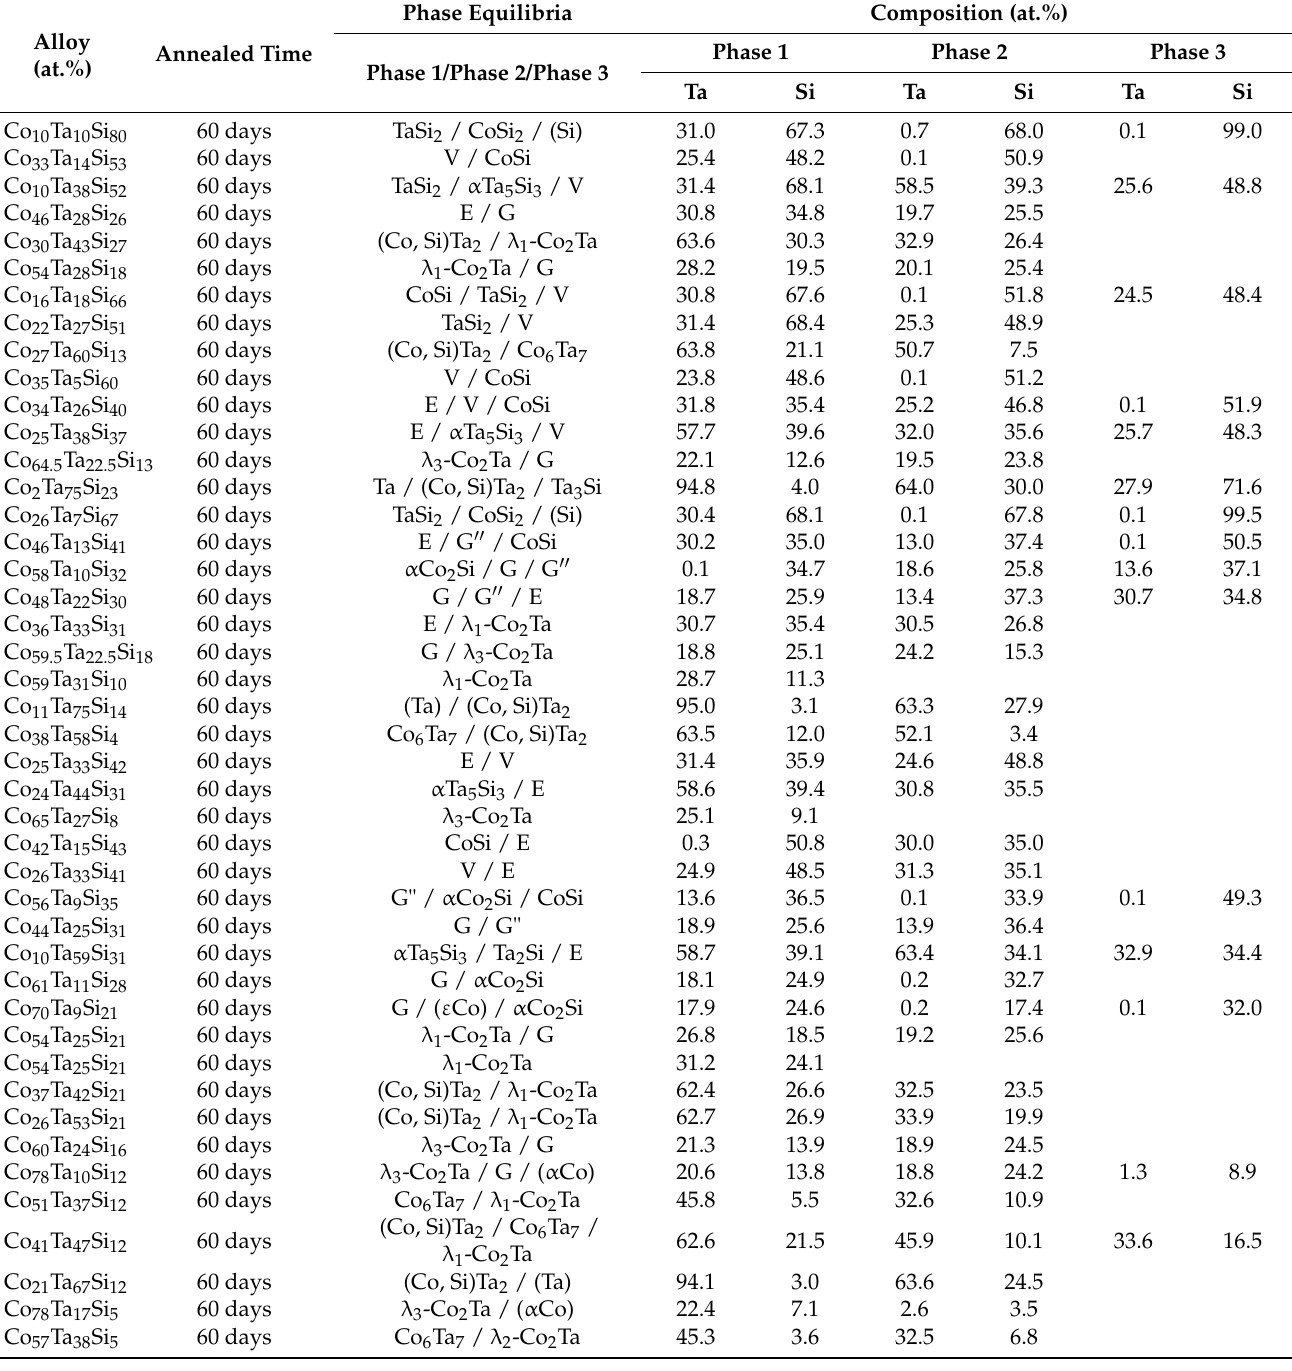
Table 3. Equilibrium compositions of the Co-Ta-Si ternary system at 1100 ◦ C determined in the present